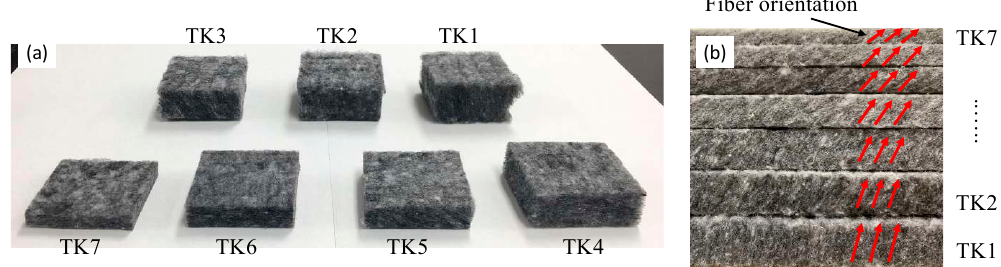
Figure 3. Longitudinal images of fibers: ( a ) staple fiber; ( b) hollow fiber; ( c ) bi-component fiber. The polyester nonwoven samples and their cross-sectional macroscopic images are illustrated in Figure 4. It can be seen that the decrease in thickness resulted in an increase in the fiber orientation angle. One tomography image of sample TK7 is presented in Figure 5. The x-ray micro computerized tomography was performed at the Technical University of Liberec, Czech Republic on a Bruker SKYSCAN 1272 (Billerica, MA, USA). Software CTVOX 3.3 was used to reconstruct the tomography image.